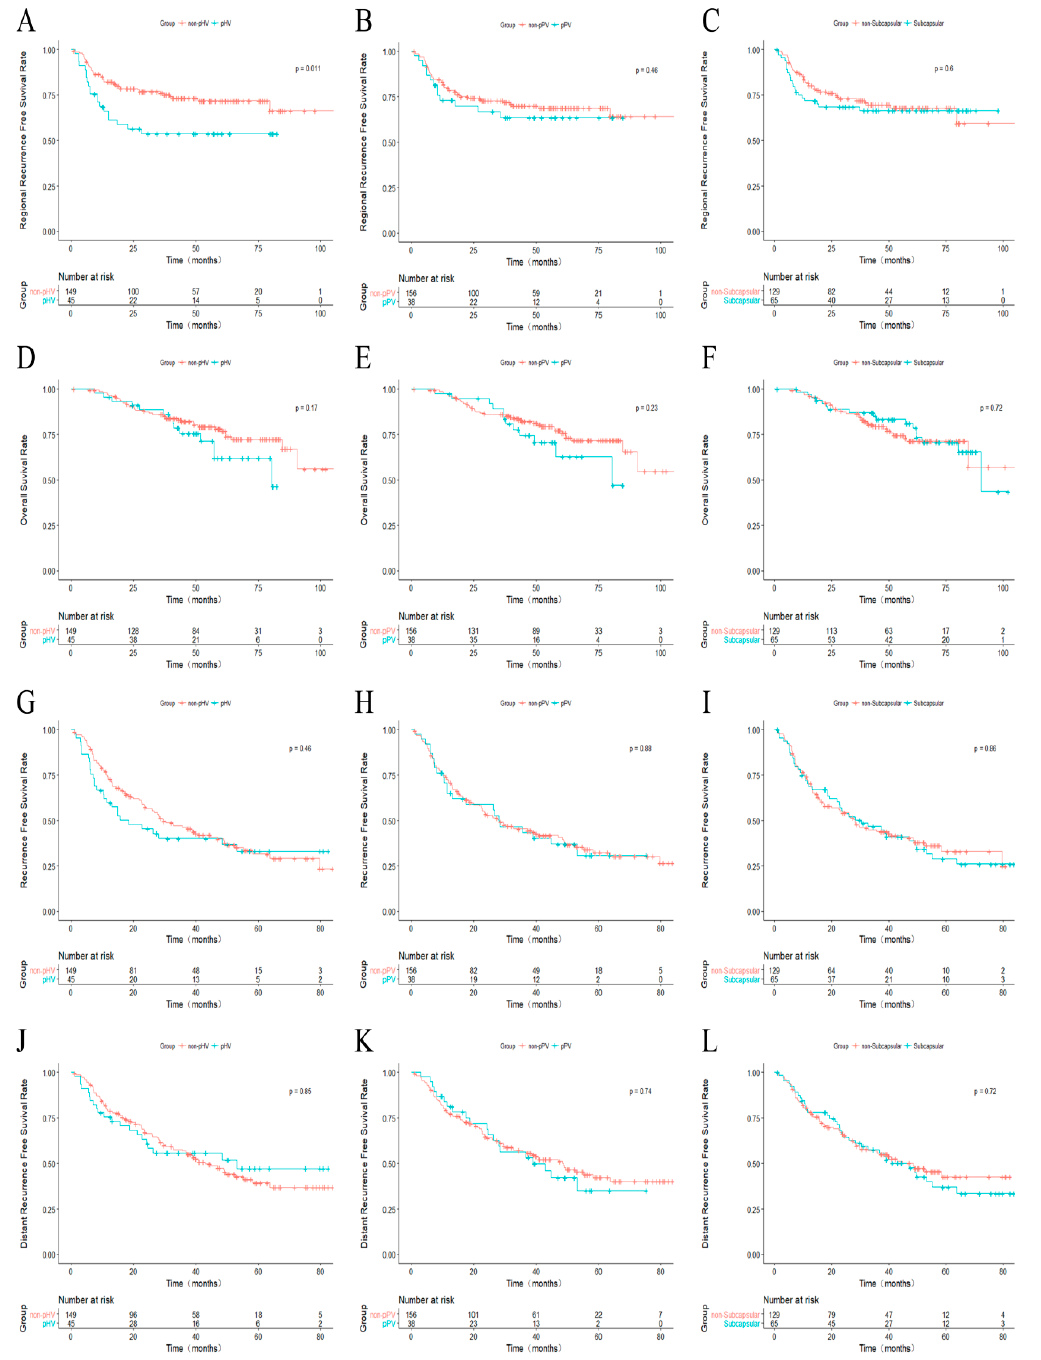
Figure 2. Kaplan–Meier curves comparing recurrence and overall survival from different groups. ( A – C ) Comparing rRFS between non-pHV and pHV ( A ), non-pPV and pPV ( B ), subcapsular and non-subcapsular ( C ) HCCs; ( D – F ) comparing OS between non-pHV and pHV ( D ), non-pPV and pPV ( E ), subcapsular and non-subcapsular ( F ) HCCs; ( G – I ) comparing RFS between non-pHV and pHV ( G ), non-pPV and pPV ( H ), subcapsular and non-subcapsular ( I ) HCCs; ( J – L ) comparing dRFS between non-pHV and pHV ( J ), non-pPV and pPV ( K ), subcapsular and non-subcapsular ( L ) HCCs. pHV: peri-hepatic vein; pPV: peri-portal-vein; HCC, hepatocellular carcinoma; rRFS: regional recurrence-free survival; OS: overall survival; RFS: recurrence-free survival; dRFS, distant recurrence-free survival.